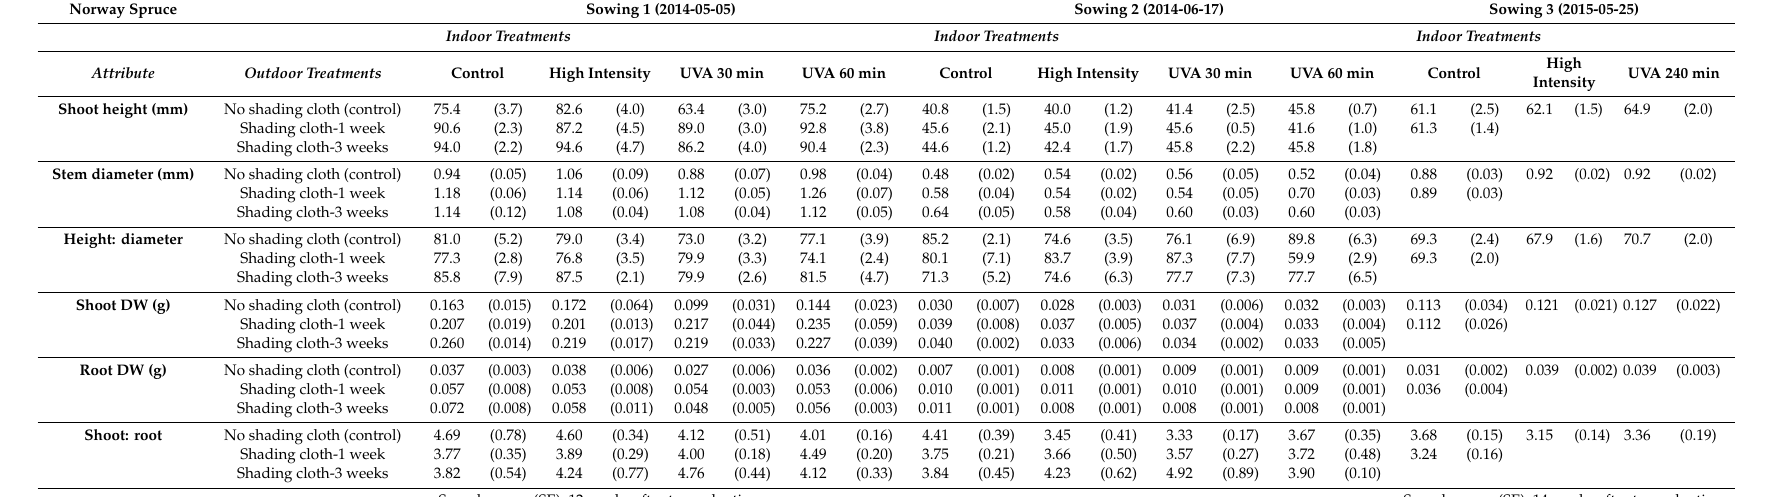
Table A1. Material attributes of Norway spruce seedlings after one vegetation